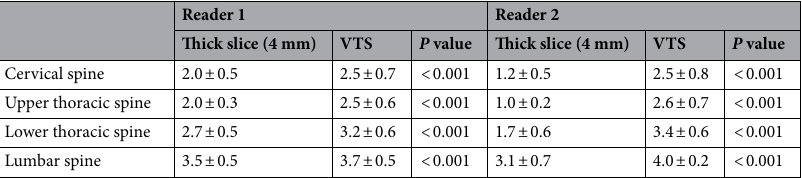
Table 2. Mean scores of visibility of intervertebral spaces. Data are mean score (rated on a 4-point scale) ± standard deviation. VTS virtual thin slice.